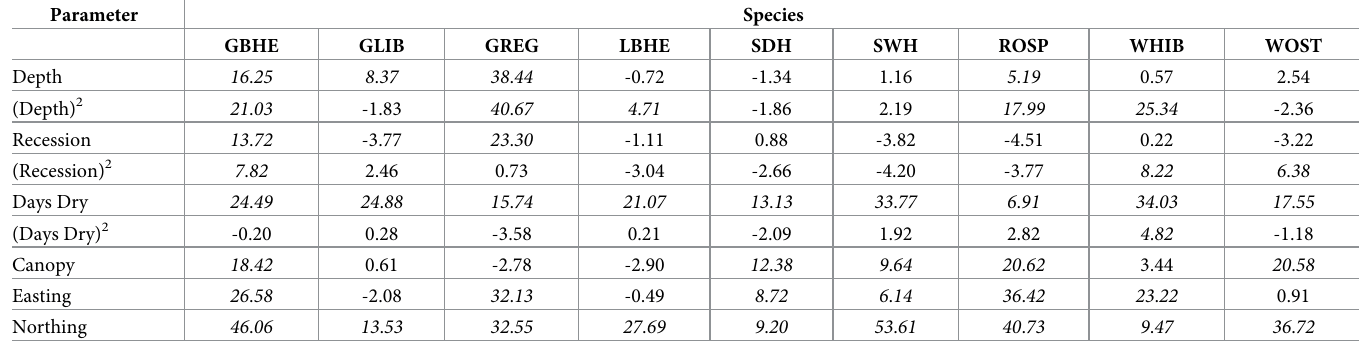
Table 3. Species-specific Bayes factors for parameters predicting species occupancy.